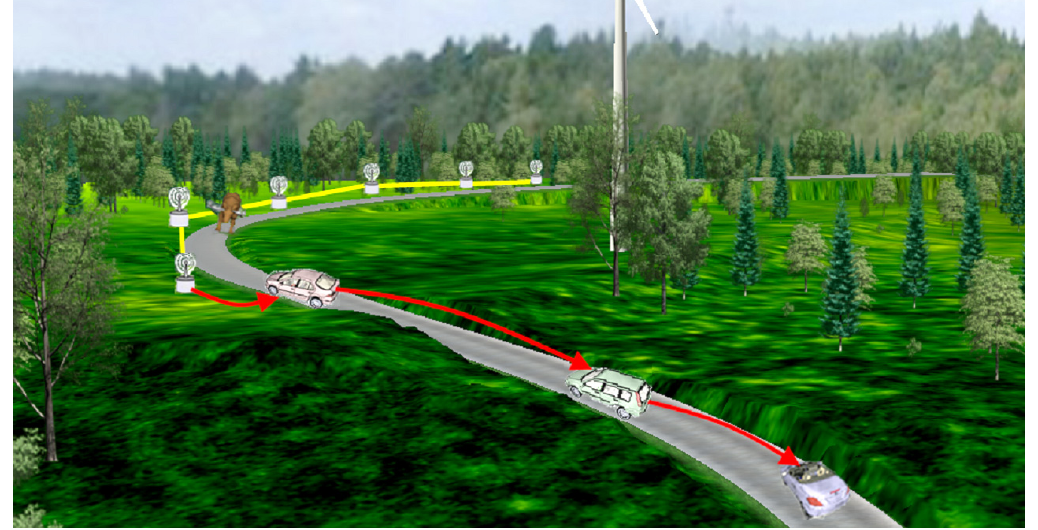
Figure 1. WSN-based ITS application